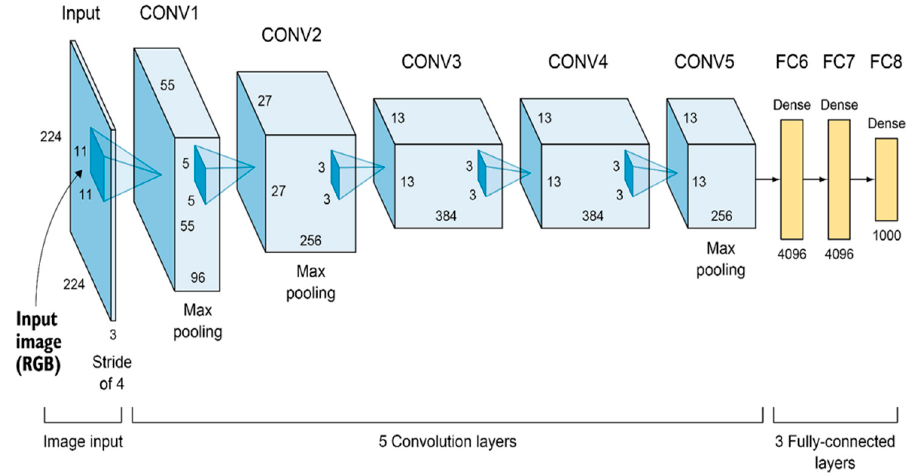
Figure 3. AlexNet architecture.